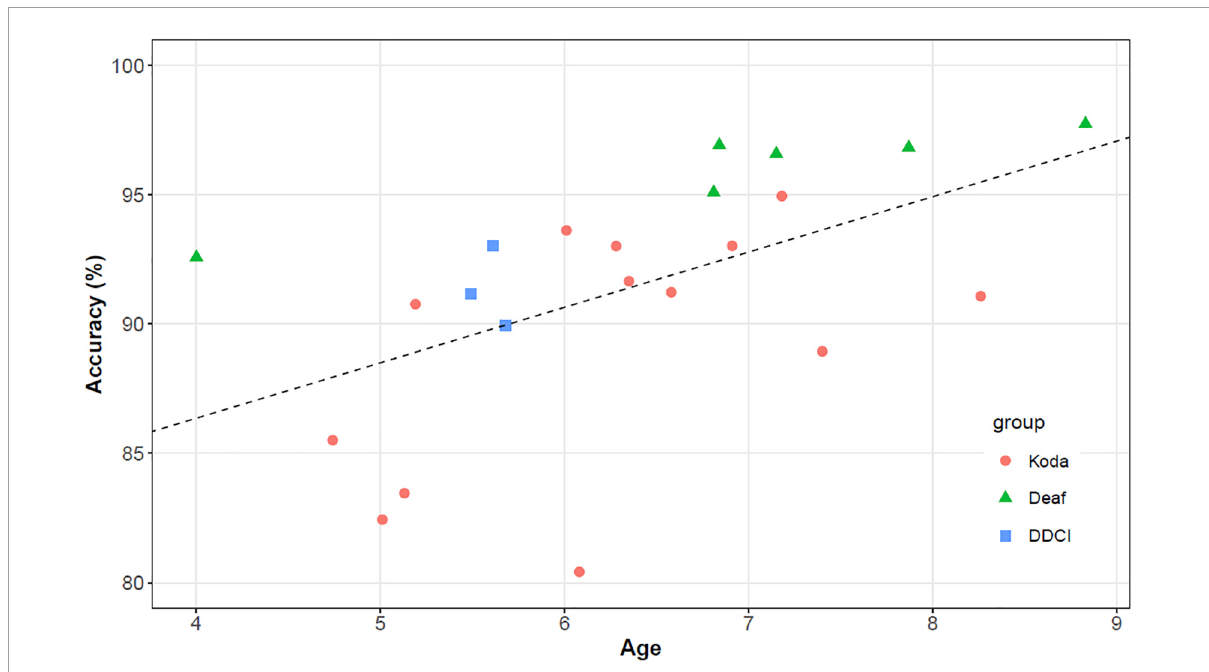
FIGURE6 Overall accuracy and its relationships to age (intercept = 0.778, slope = 0.021, p < 0.001).